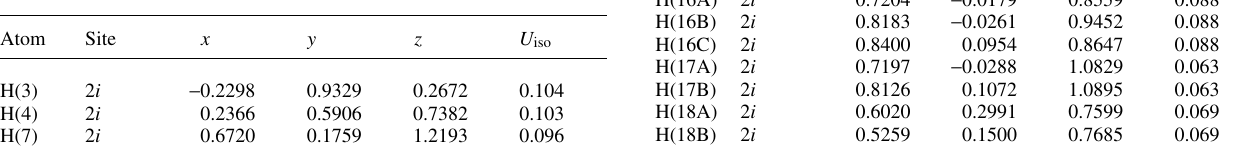
Table 2. Atomic coordinates and displacement parameters (in Å 2 ) .